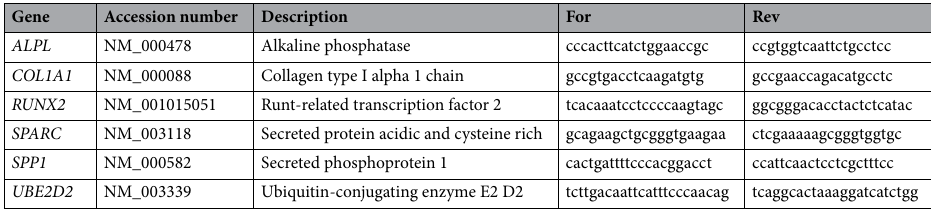
Table 1. Sequences of primers used for real-time